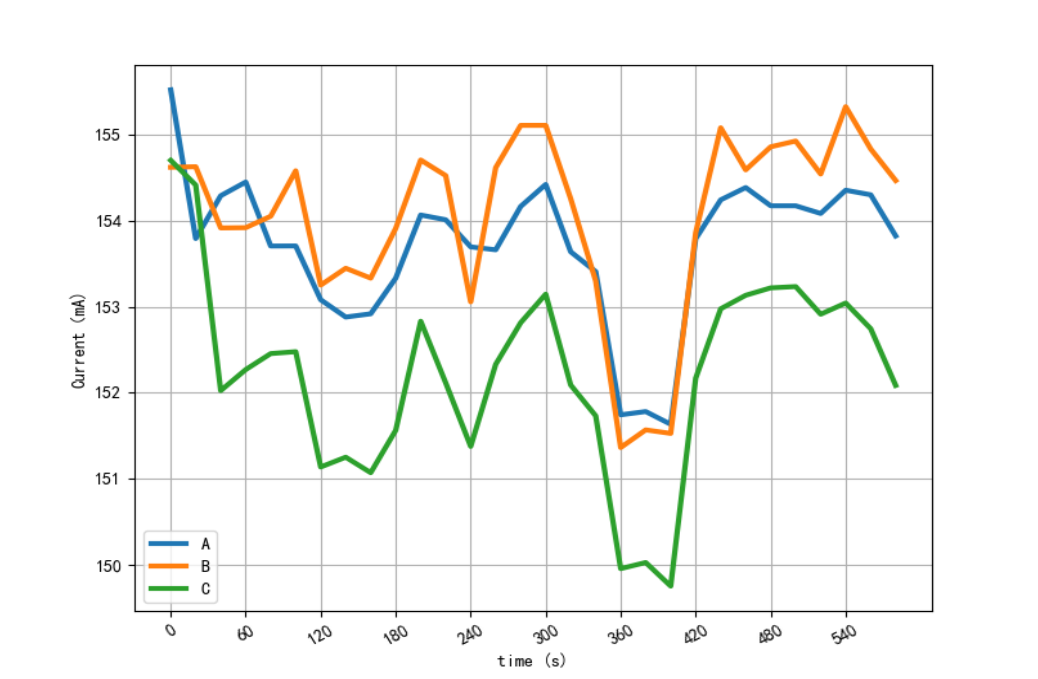
Figure 2. One sample of the 3-phase grounding current of iron core data with the fault of Phase A to ground.